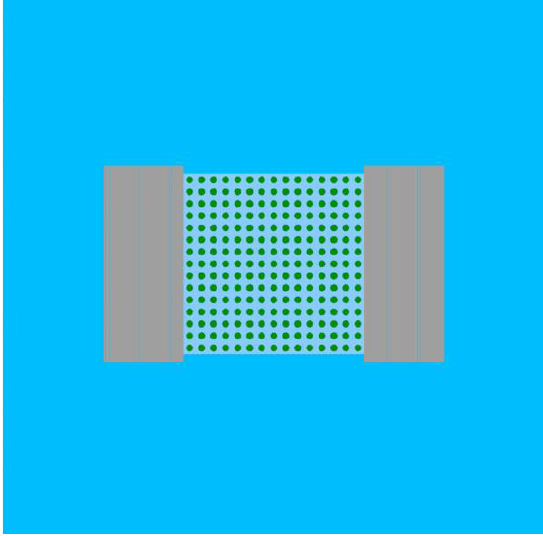
Figure 6. CASMO5 multi-assembly depiction of TCA steel-only reflector with 15.12 cm thickness.